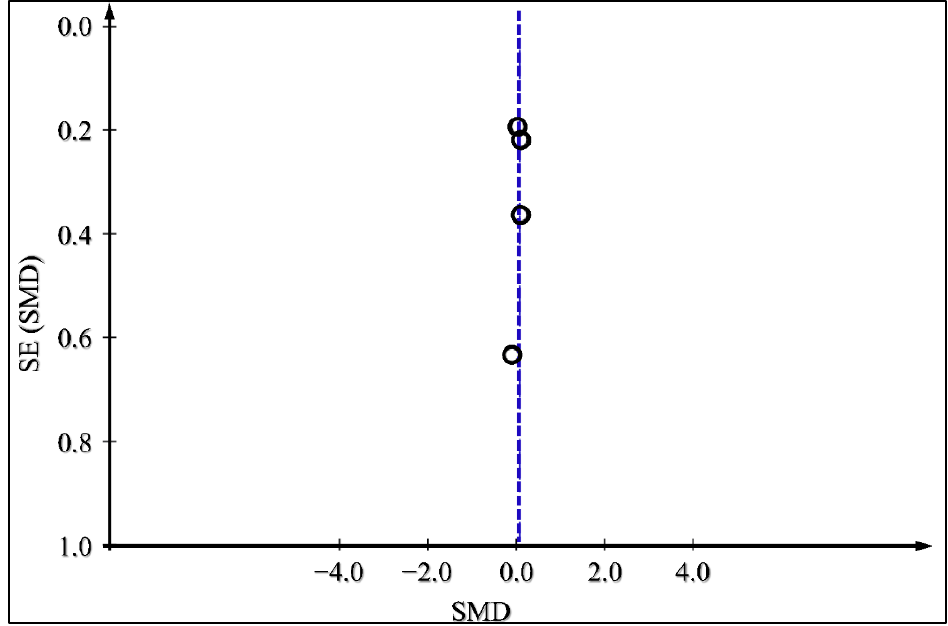
Figure 9. Funnel plot for Publication Bias Assessment for body weight.